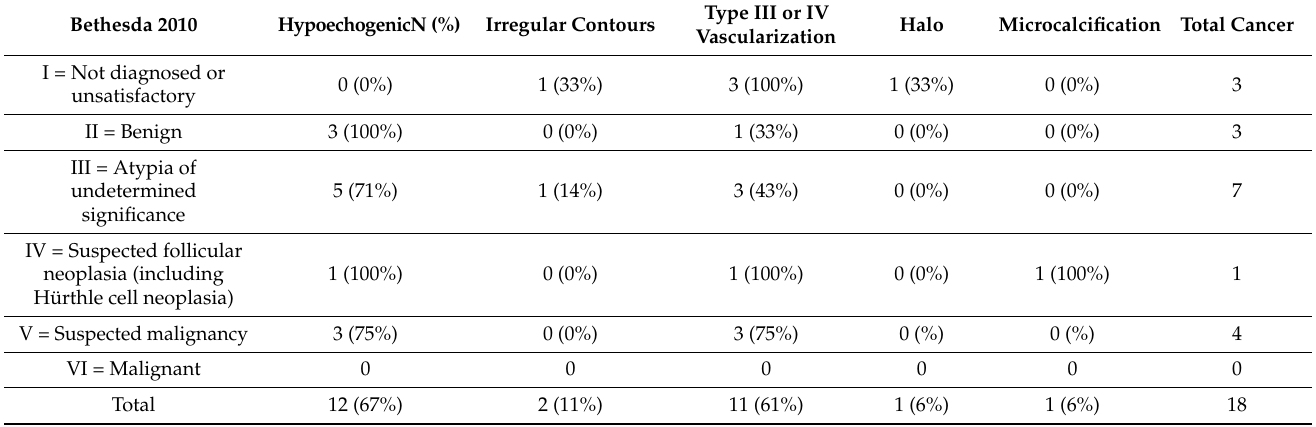
Table 3. Correspondence between Bethesda system 2010 and ultrasound characteristics in the cancer group. Number (N) and percentage (%) of nodules in each category being hypoechoic or having irregular contours, type III or IV vascularization, halo and